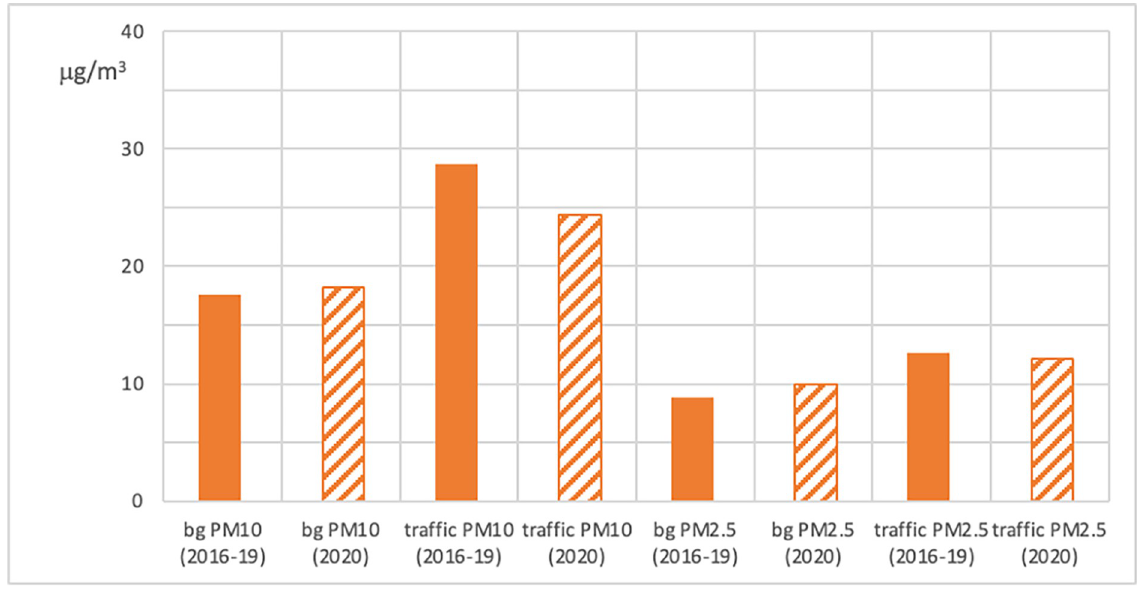
Fig 4. PM in Lisbon. PM 2.5 and PM 10 concentrations [ μ g . m -3 ] in background (bg) and traffic stations in Lisbon during LD.